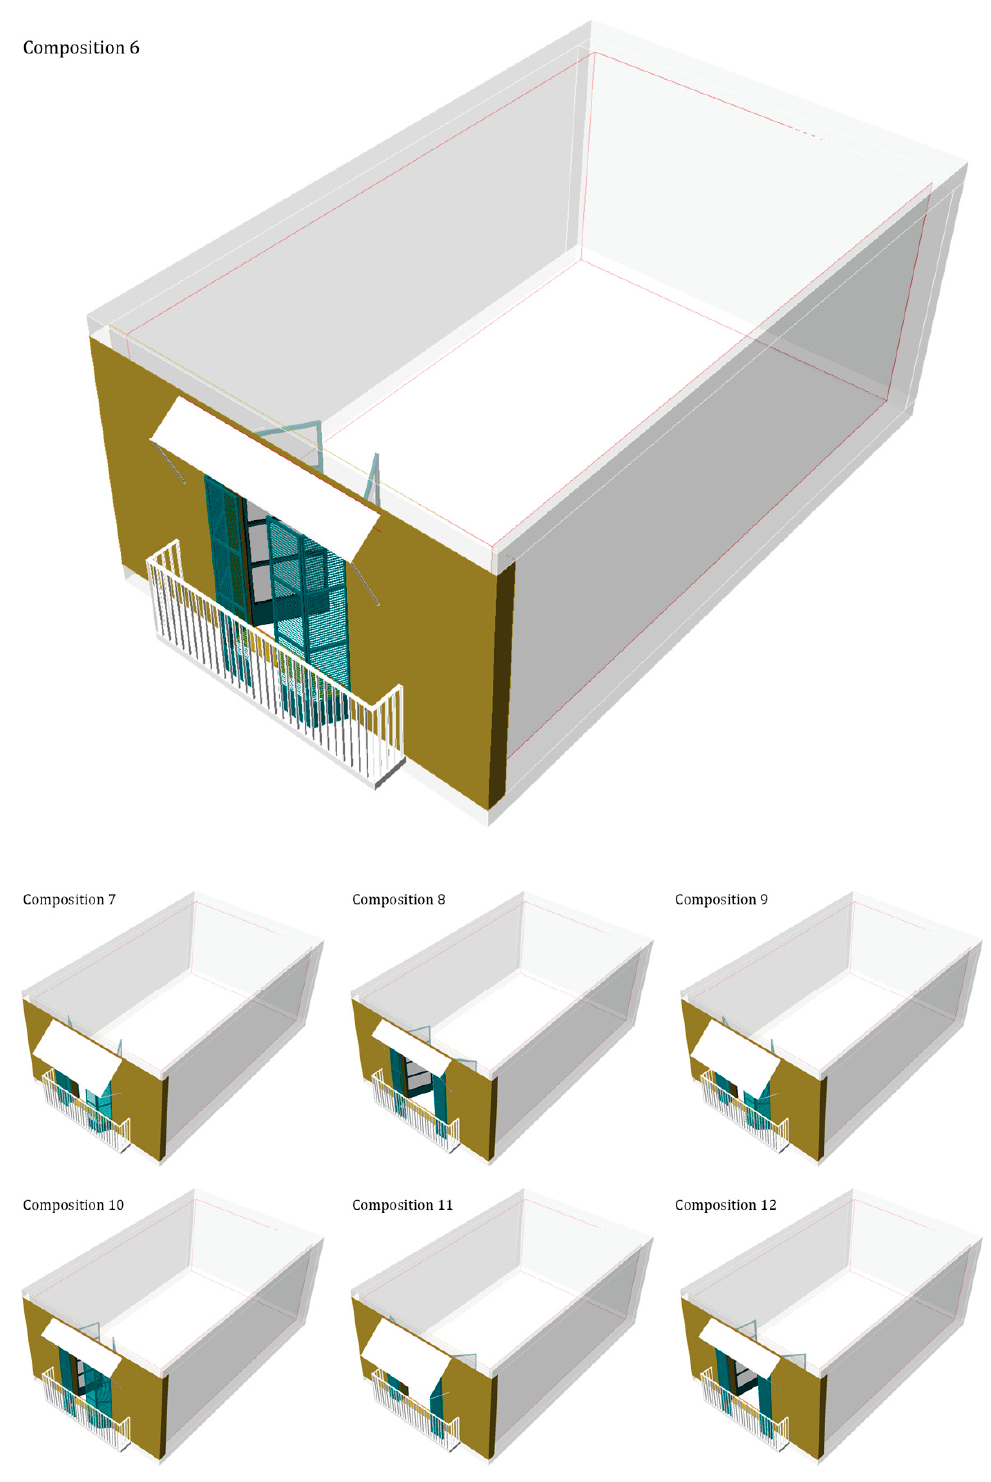
Figure 4. Perspective images of compositions of operable elements found through the described design search procedure. Thermal results related to these configurations are found in Figure 5, and show that only minor perceived temperature variations are found on 21 June. One reason for this is the external blind position, the marquise, combined with the time of the simulation. In Barcelona, the sun sits high during the summer, resulting in a shading effect even when the marquise is only minimally extracted (see results, discussion, and graphs below).